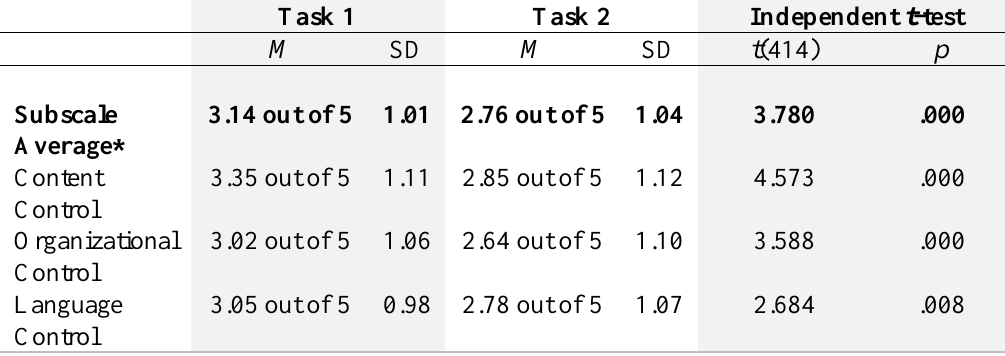
*Averaged ratings across three subscales out of 5